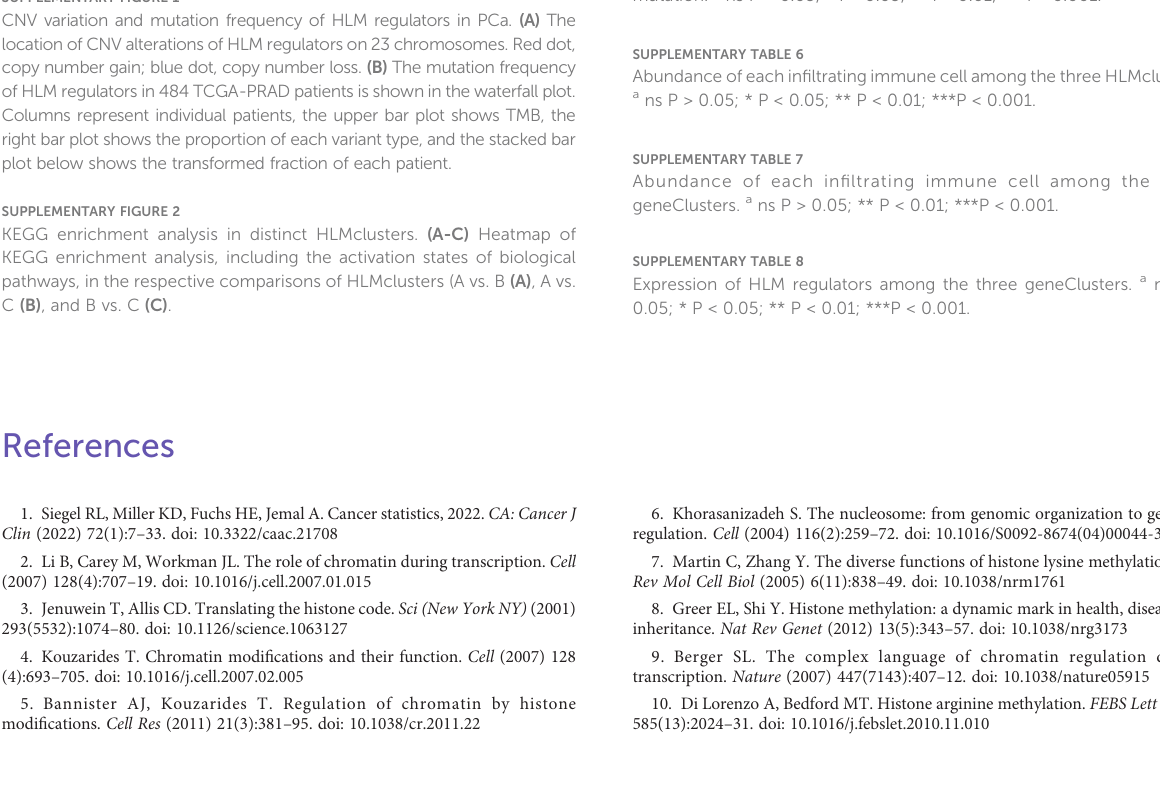
SUPPLEMENTARY TABLE 5 Expression levels of HLM regulators in TCGA-PRAD data strati fi ed by TP53 mutation. a ns P > 0.05; * P< 0.05; ** P< 0.01; ***P< 0.001.